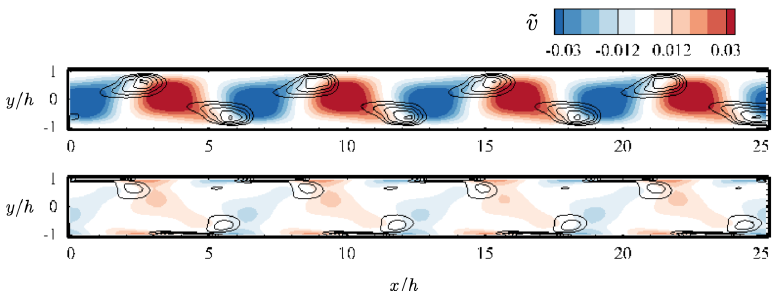
Figure 16. A comparison of instantaneous flow field at slices z / h = 0 and tu c / h = 12 between uncontrolled and controlled flow with ( α , β ) = ( 1,1 ) and E 0 = 0.5 velocity ˜ v , and black contour lines denotes of 0.01.